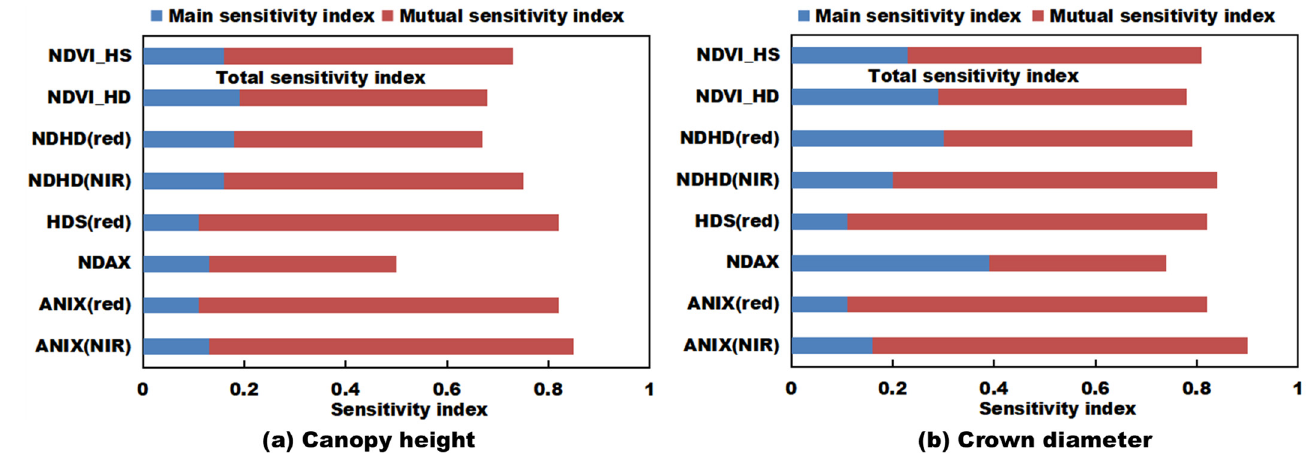
Figure 4. Sensitivity analysis of BRDF shape indicators on forest biomass-related forest canopy structure parameters (i.e., canopy height and crown diameter); all of these indexes are constructed by typical-angle reflectances in red and NIR bands (i.e., hotspot, nadir, and darkspot), of which 1 is the most sensitive; ( a ) is the result for canopy height, ( b ) is the result for crown diameter.